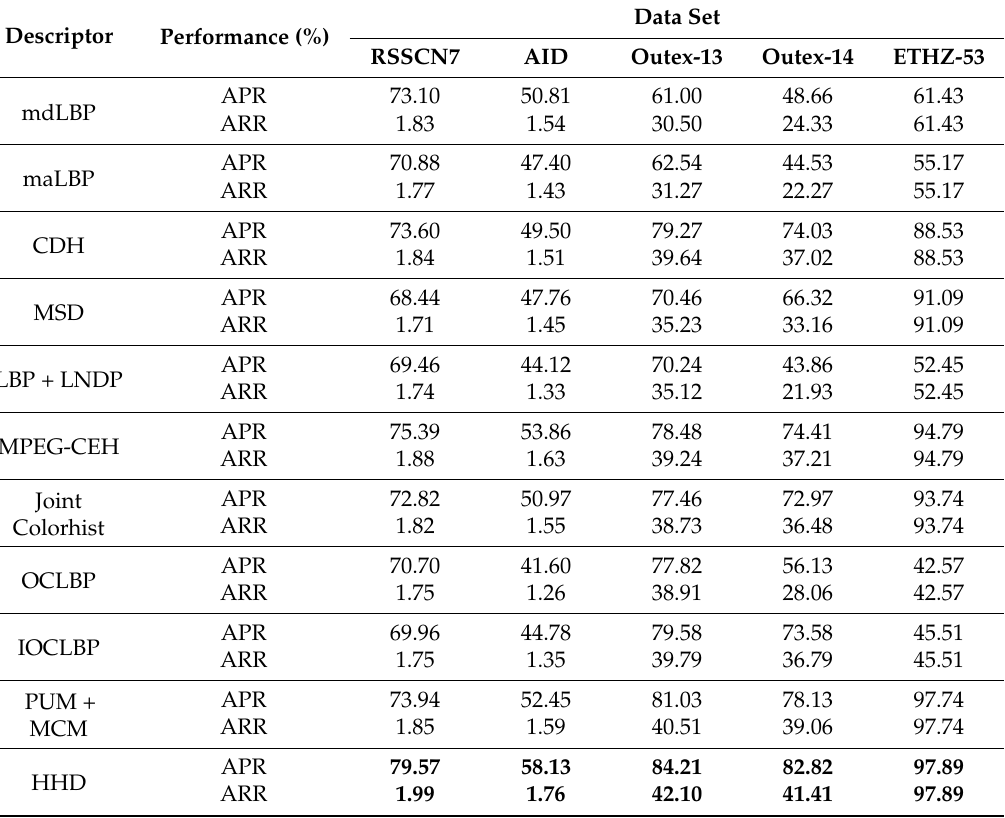
Table 8. Average precision rate (APR) and average recall rate (ARR) of different methods over RSSCN7, AID, Outex-00013, Outex-00014 and